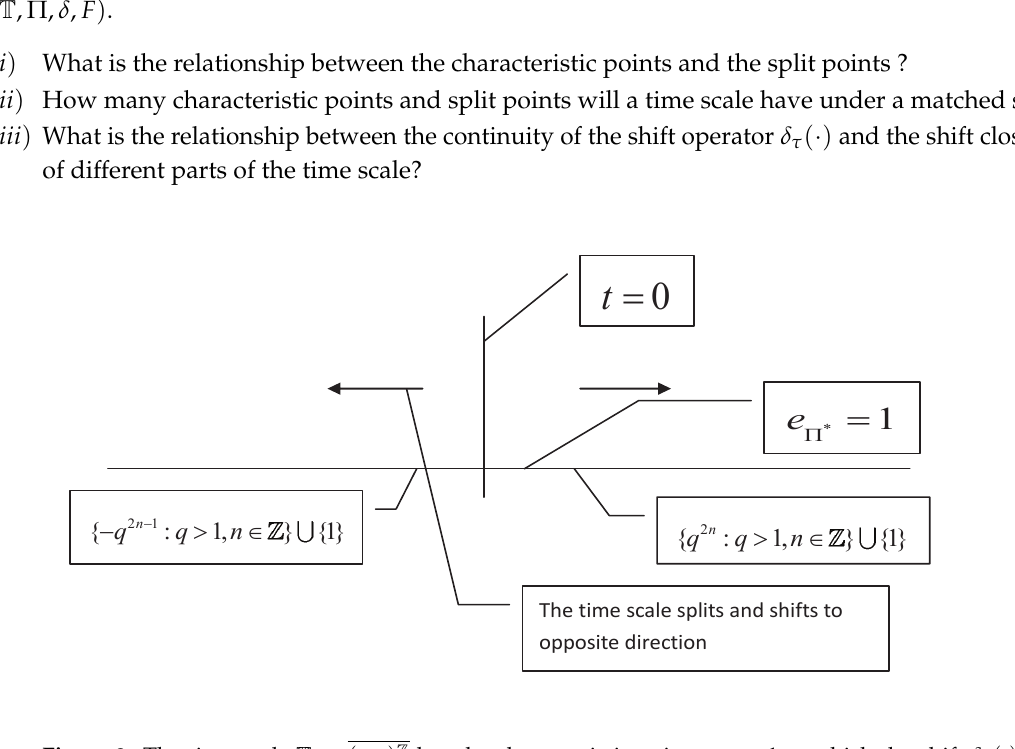
Figure 3. The time scale T = ( − q ) Z has the characteristic point e Π ∗ = 1 at which the shift δ τ ( · ) is discontinuous. This time scale splits at t = 0 and has the opposite shift closedness at the split point.